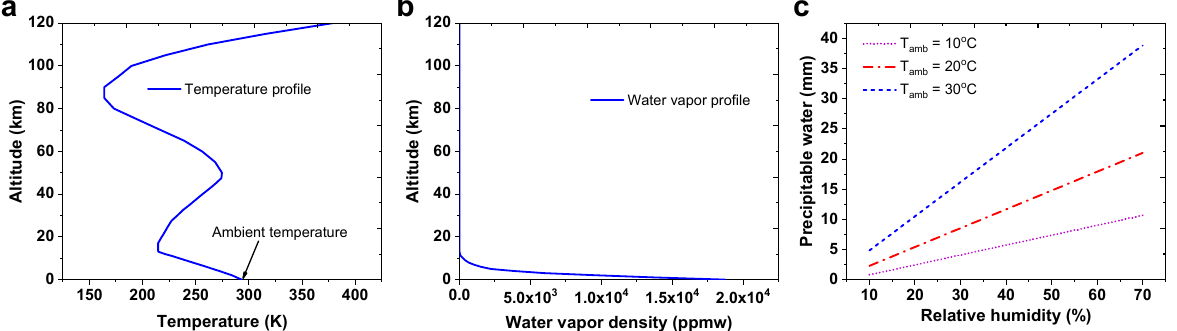
Figure 2. Example atmospheric profiles used in the modeling of an instance of atmospheric effective emissivity. The profiles are from the default mid-latitude summer atmosphere model in MODTRAN. ( a ) Altitude-dependent temperature profile, where T amb = 293 K. ( b ) Altitude-dependent water vapor density profile. ( c ) Estimated precipitable water vs relative humidity at T amb = 10, 20, 30 °C, respectively.